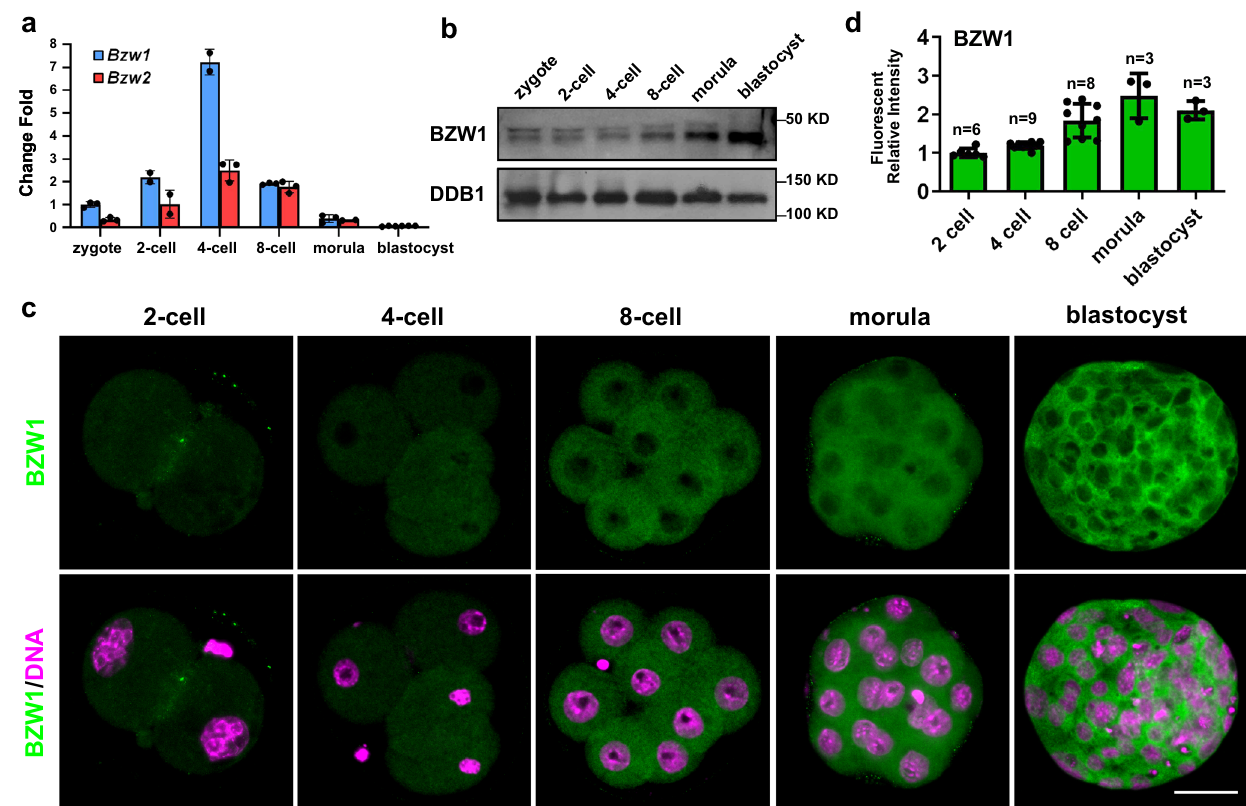
Fig. 1 | BZW1 is a cytoplasmic protein that is continuously expressed during embryonic development. a Absolute quantitative RT-PCR results for Bzw1 and Bzw2 expressioninmousepreimplantationembryos.The expressionlevelsateach developmental stage were normalized to Gapdh , which served as an internal con- trol.TherelativemRNAlevelof Bzw1 atthezygotestagewasde fi nedas1.0.Dataare presented as mean values. Error bars indicate the standard deviation (SD) ( fi ve embryos were collected at each time point). b Protein levels of BZW1 in mouse preimplantation embryos were determined by western blot analysis. DDB1 was blottedasa loadingcontrol.Totalprotein samples from